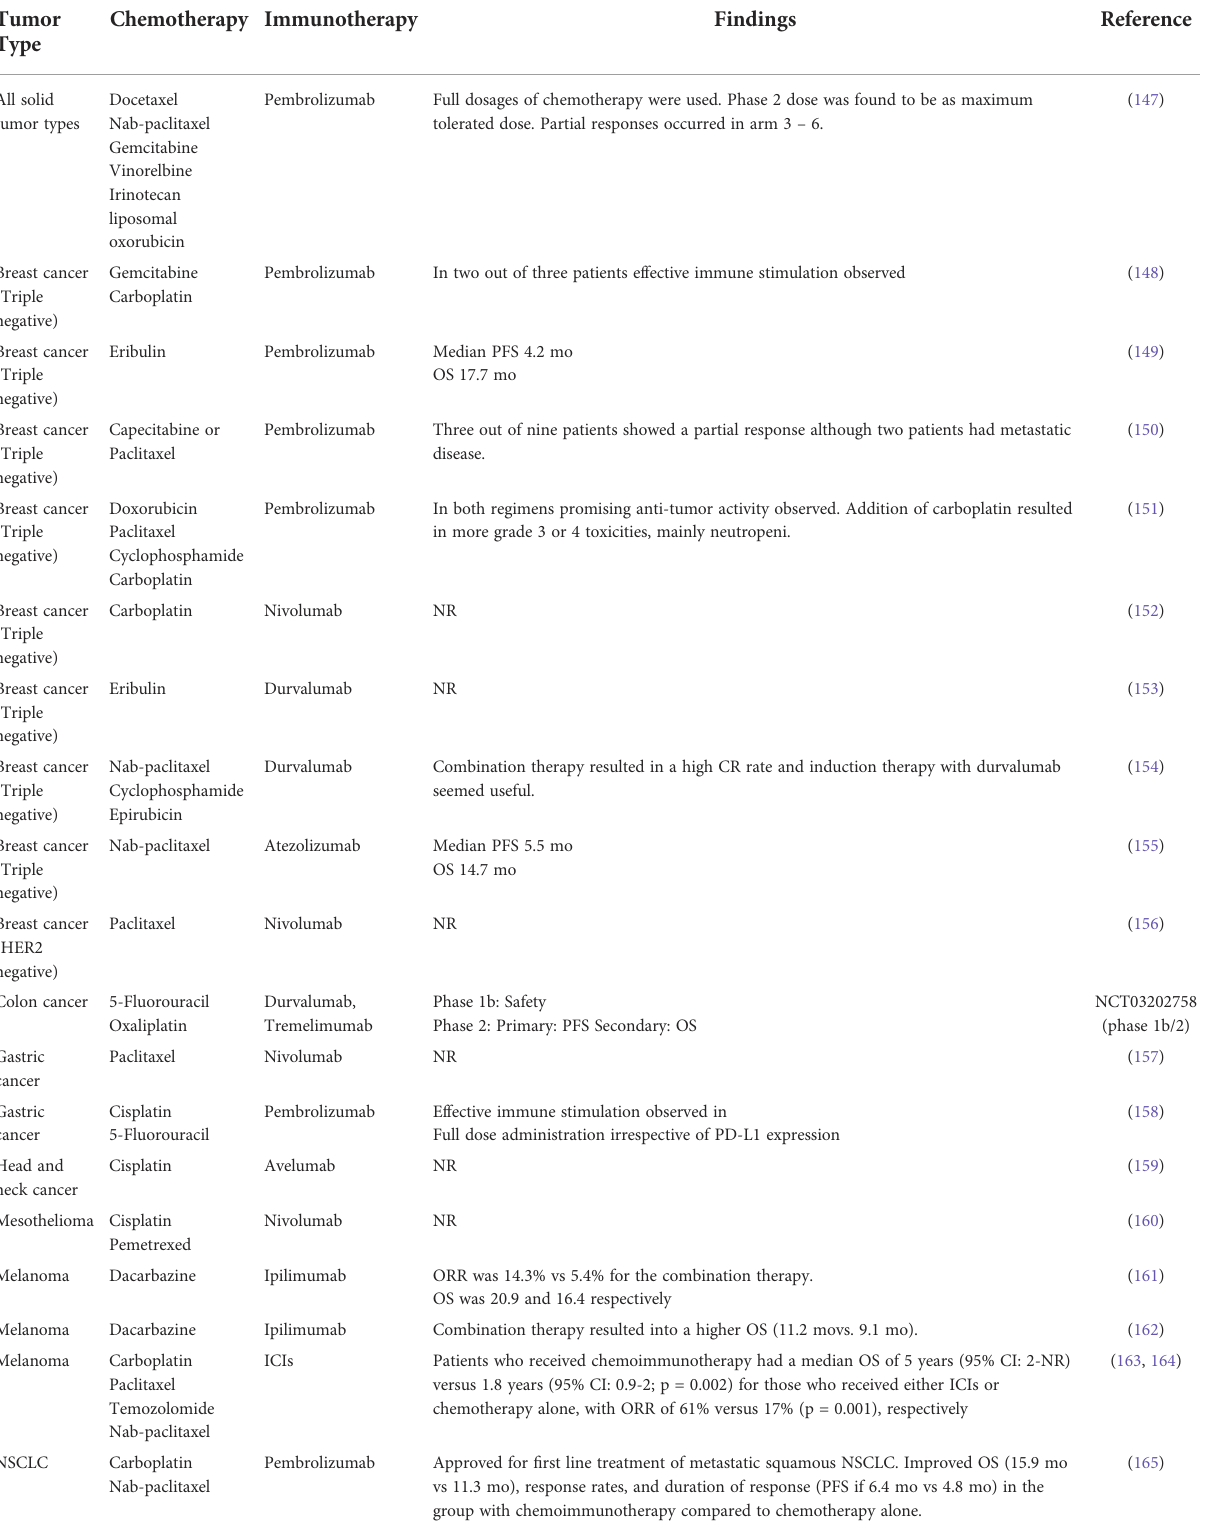
TABLE 1 Different clinical trials using combination